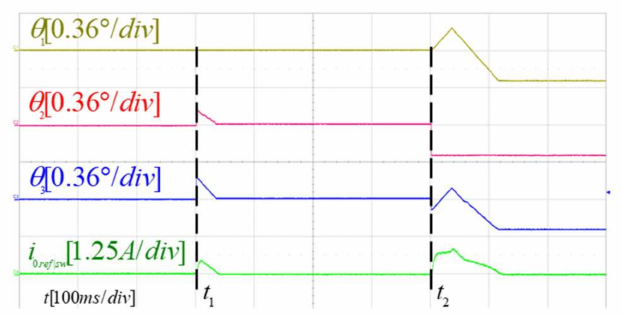
Figure 15. Trends of the carrier phases of individual inverters and the reference zero − sequence current during control of phase errors occurred during normal